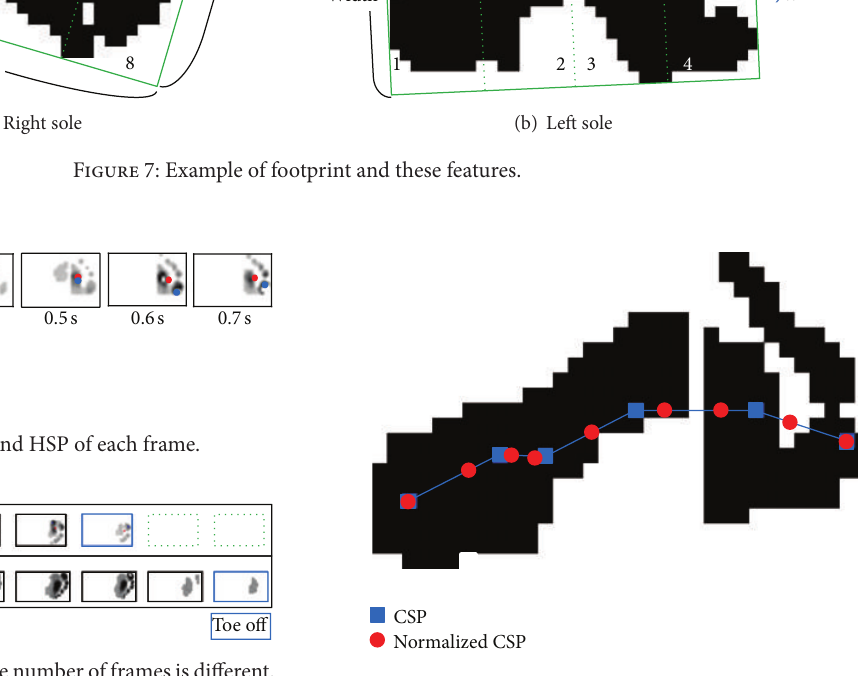
Figure 10: An example of CSPs trajectory and nine normalized CSPs.